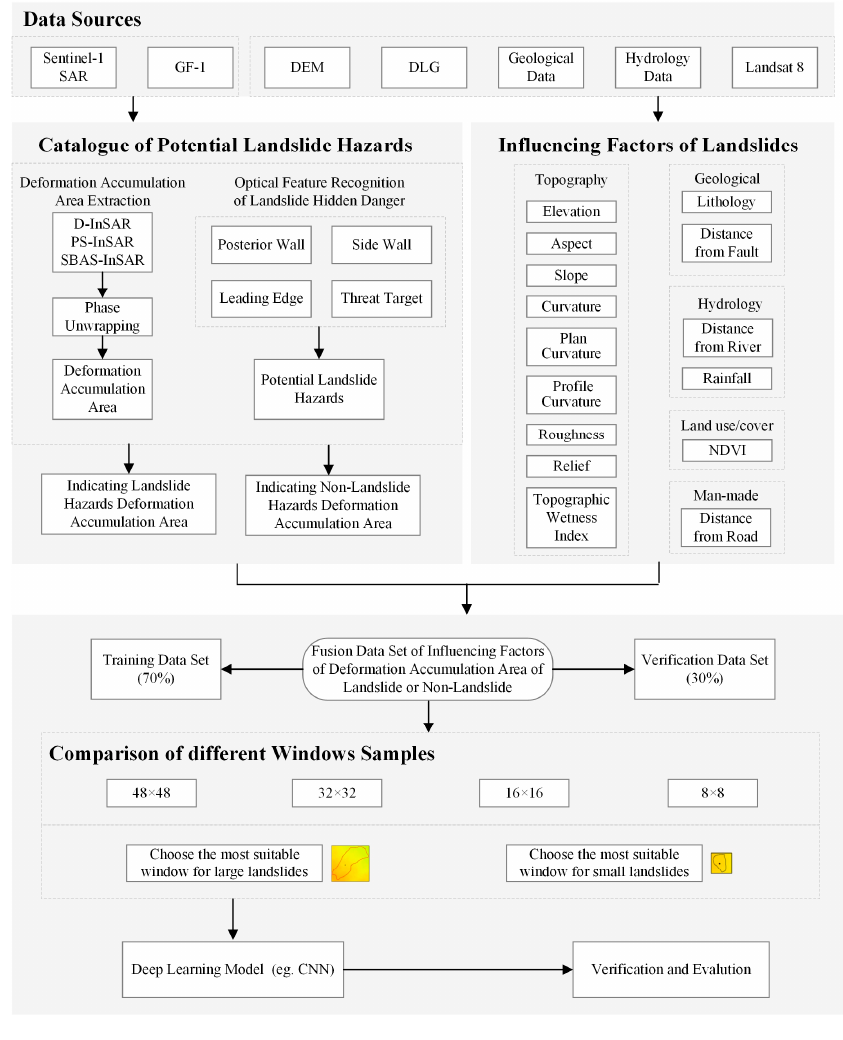
Figure 1. Flow chart.